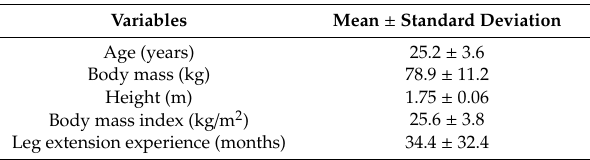
Table 1. Characteristics of subjects.